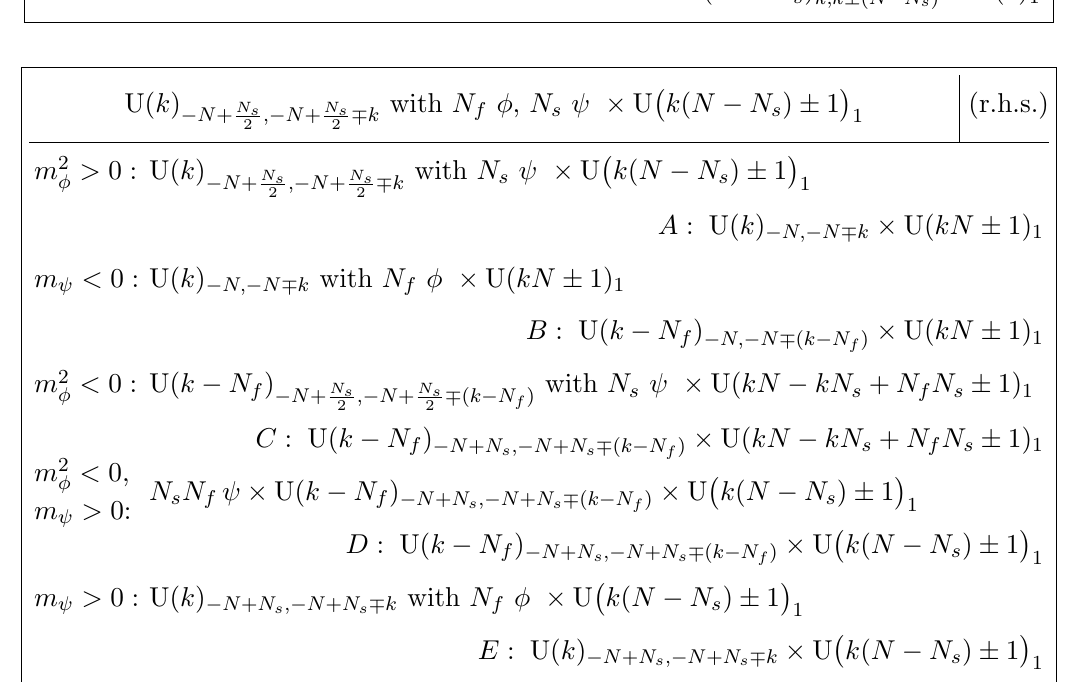
Table 3 . Phase diagram of the U / U dualities. These tables are valid for N s